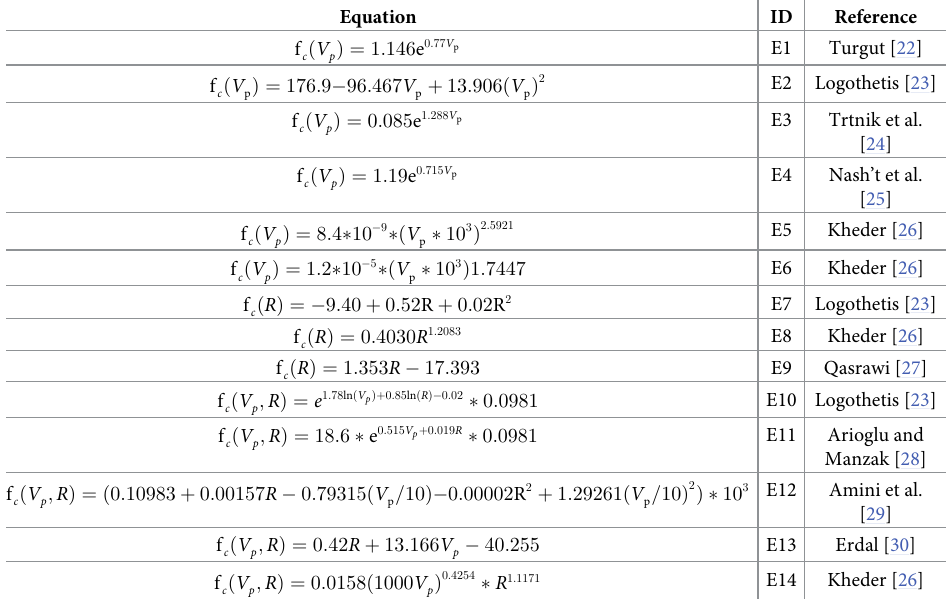
Table 7. Empirical relational expressions for estimating the compressive strength of concrete.